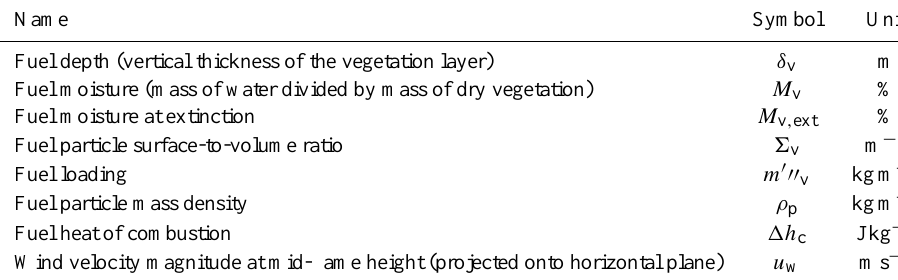
Table 1. Input parameters of the Rothermel-based ROS sub-model. Name Symbol Unit Fuel depth (vertical thickness of the vegetation layer) δ v m Fuel moisture (mass of water divided by mass of dry vegetation) M v Fuel moisture at extinction Fuel particle surface-to-volume ratio (cid:54) v Fuel